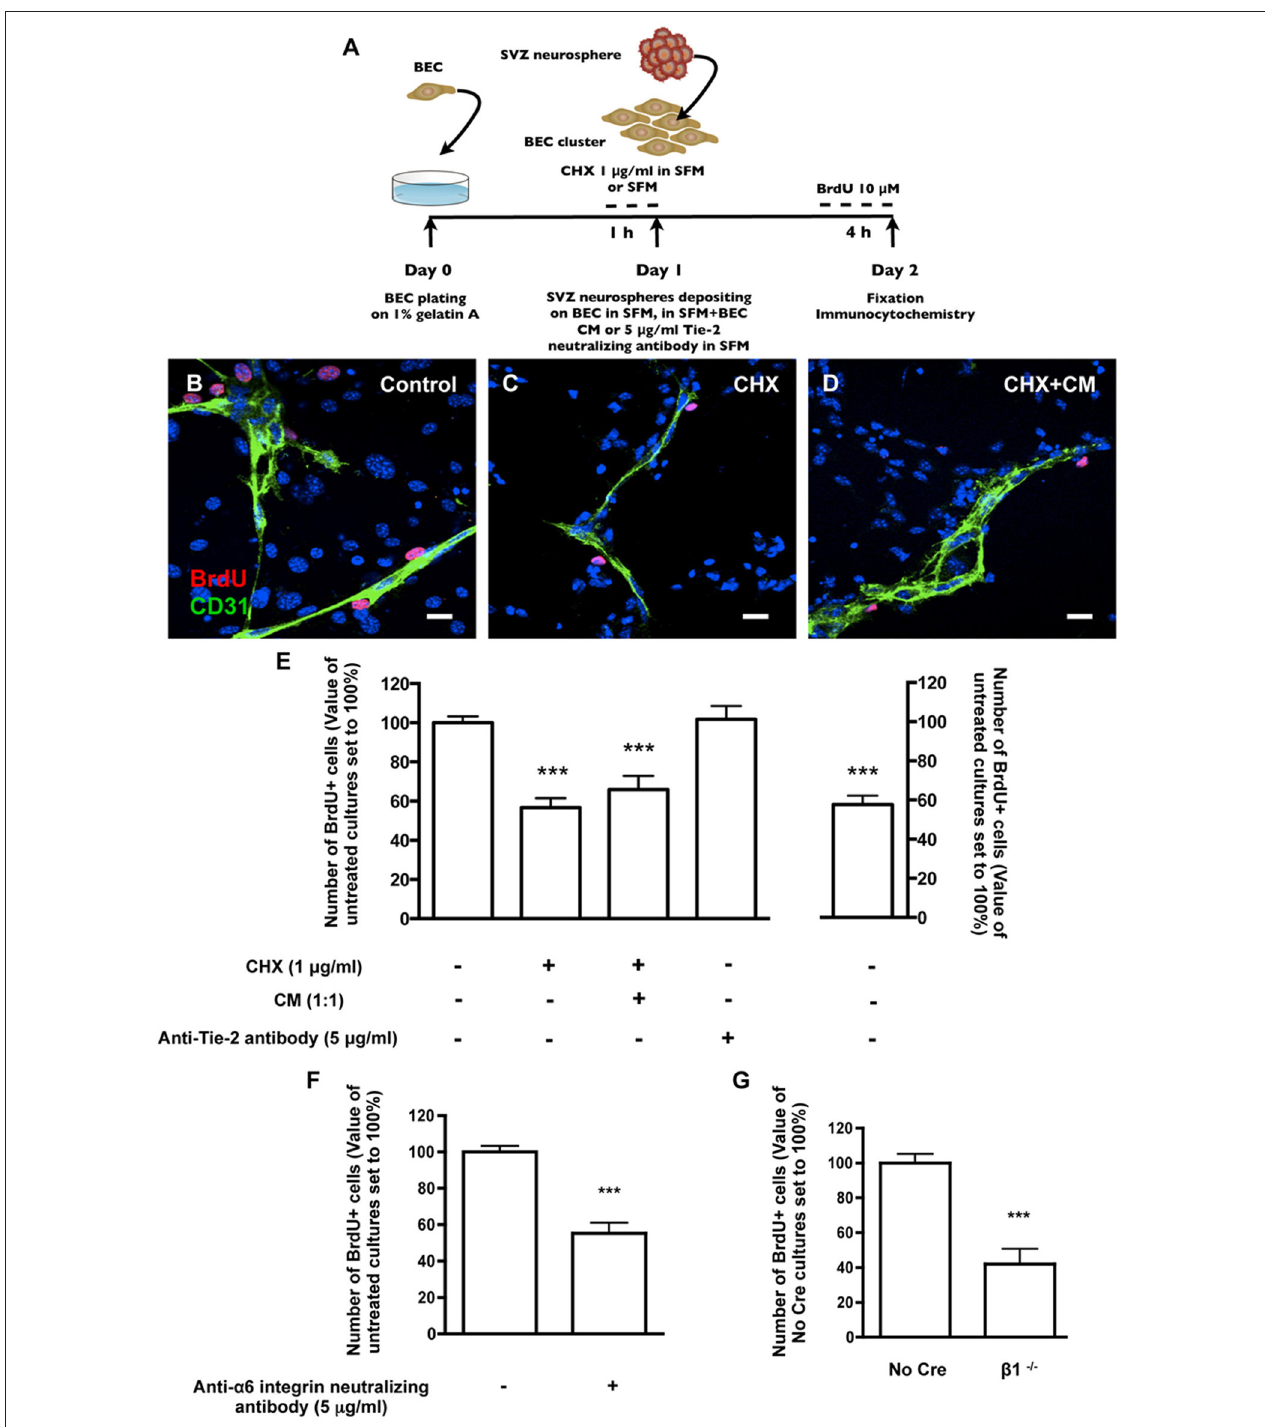
FIGURE 3 | Heterocellular contacts with BEC promote SVZ cell proliferation. (A) Experimental protocol. (B–D) Representative confocal digital images depicting proliferating cells in BEC and SVZ cells cocultures (green staining for CD31, red staining for BrdU and Hoechst 33342 staining in blue). (B) Control cocultures. (C) Cocultures with CHX-treated BEC, in SFM. (D) Cocultures with CHX-treated BEC, in SFM and BEC-CM (1:1). Scale bars, 20 µ m. (E) Left: Bar graphs show the number of BrdU + cells as a percentage of the total cells contacting BEC. Right: Graph displays the number of proliferating cells as a percentage of the total number of cells in the pseudomonolayer of SVZ cells, i.e., non-contacting BEC. Control values were normalized to 100%. *** P < 0.001, using one-way ANOVA. (F,G) α 6 β 1 integrin mediates proliferation induced by contact with BEC. Bar graph shows the number of BrdU + cells as a percentage of the total cells contacting BEC in Control cocultures, in anti- α 6 integrin neutralizing antibody-incubated cocultures (F) and in cocultures with β 1 − / − SVZ cells (G) . *** P < 0.001 using the unpaired t -test for comparison to Control or No Cre cocultures.